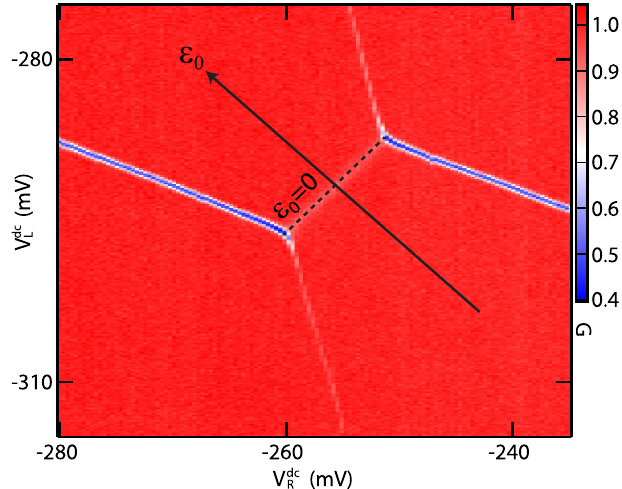
FIG. 5. Cavity power gain G plotted as a function of V dc 0 , showing the charge stability diagram of the V dc , with eV ac ¼ L DQD. The detuning axis is shown by the solid black